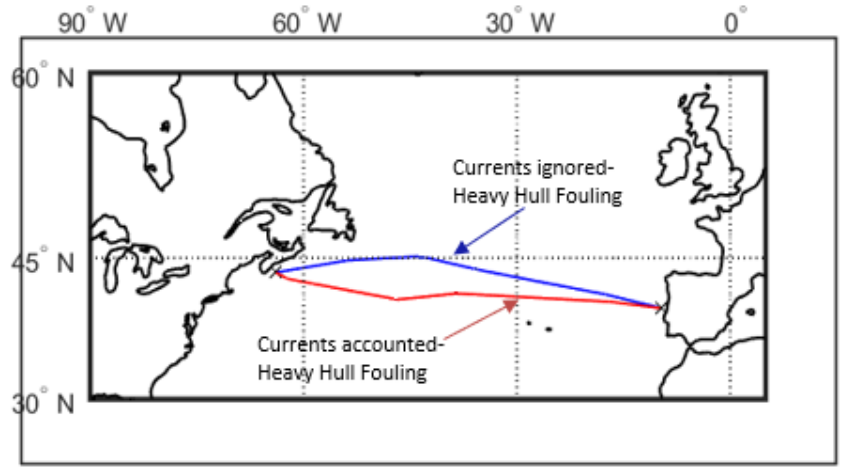
Figure 18. Optimal paths with (red route) and without (blue path) the currents’ effect under heavy hull fouling conditions.